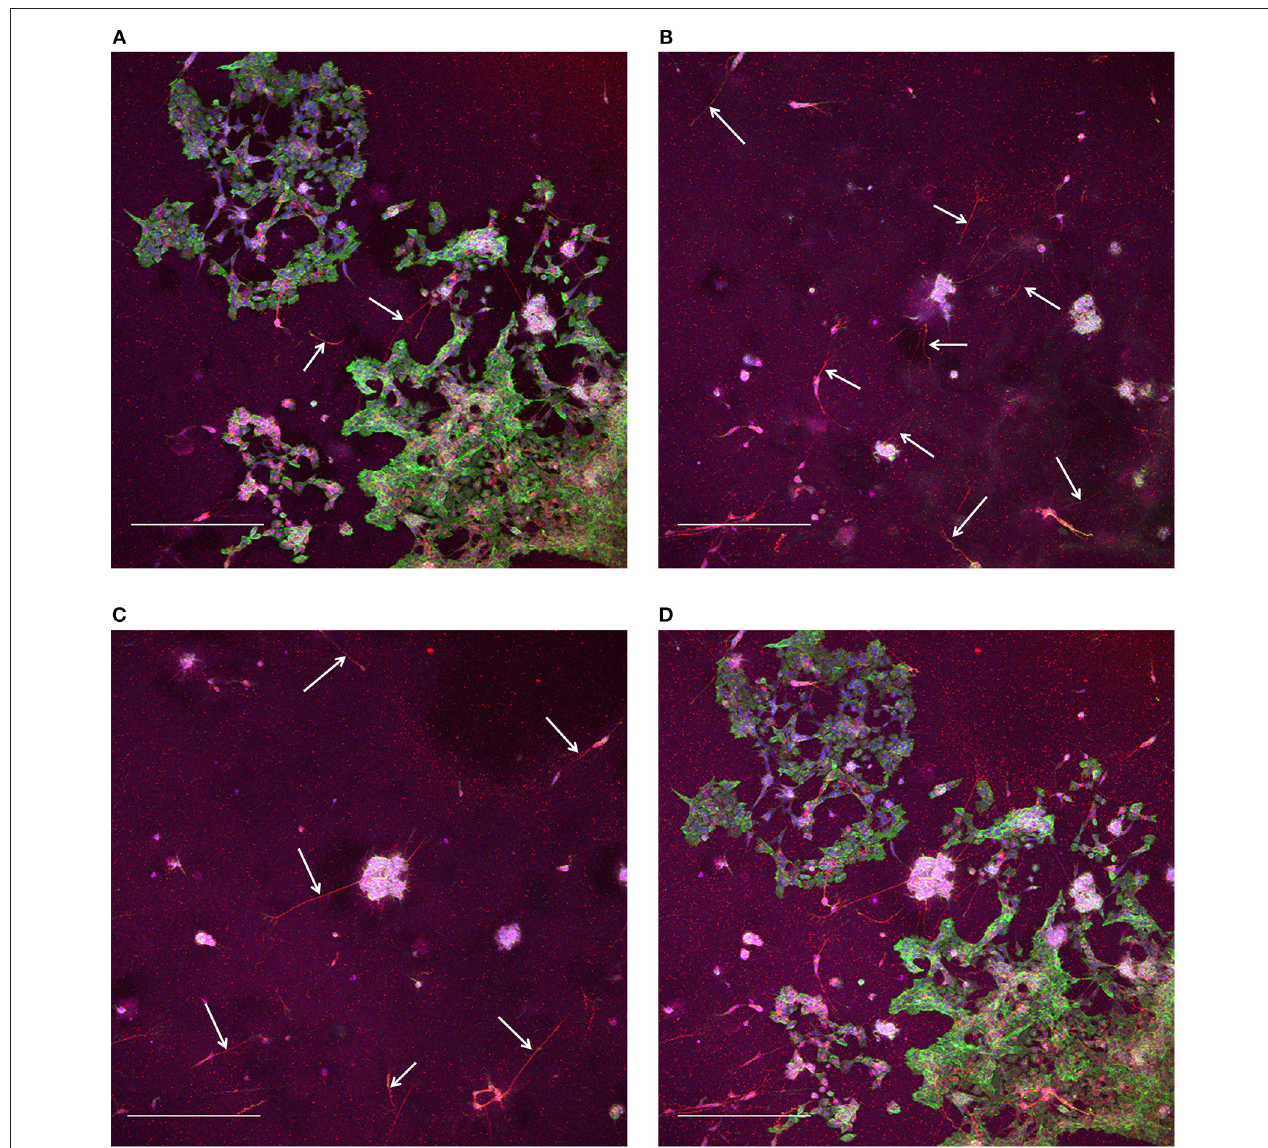
FIGURE 4 | Confocal laser scanning microscopy of 3D SH-SY5Y cells in the microbioreactor. (A) Maximum intensity projection of slices for the range of 0–33.8 µ m away from the bottom surface. (B) Maximum intensity projection of slices for the range of 35.1–106.6 µ m away from the bottom surface. (C) Maximum intensity projection of slices for the range of 107.9–184.6 µ m away from the bottom surface. (D) Maximum intensity projection the complete z-stack with a range of 184.6 µ m and slices at a 1.3 µ m interval. The staining shows red for neuron-specific protein β -Tubulin III, green for actin, and blue for cell nuclei for (A–D) . The scale bars denote 400 µ m. White arrows in (A–C) indicate neuronal